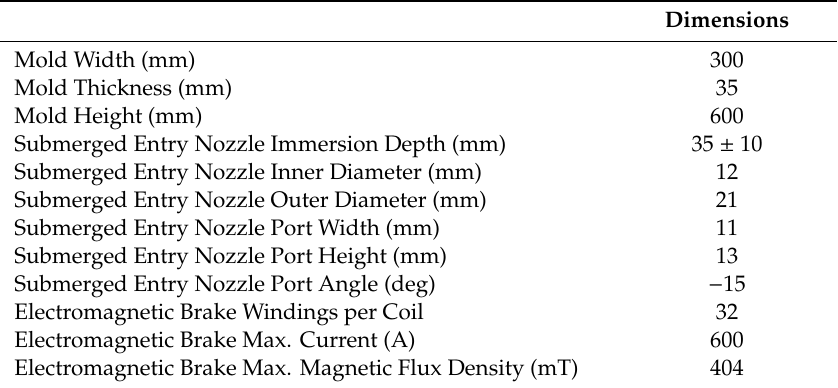
Table 2. Dimensions of the Mini-LIMMCAST setup